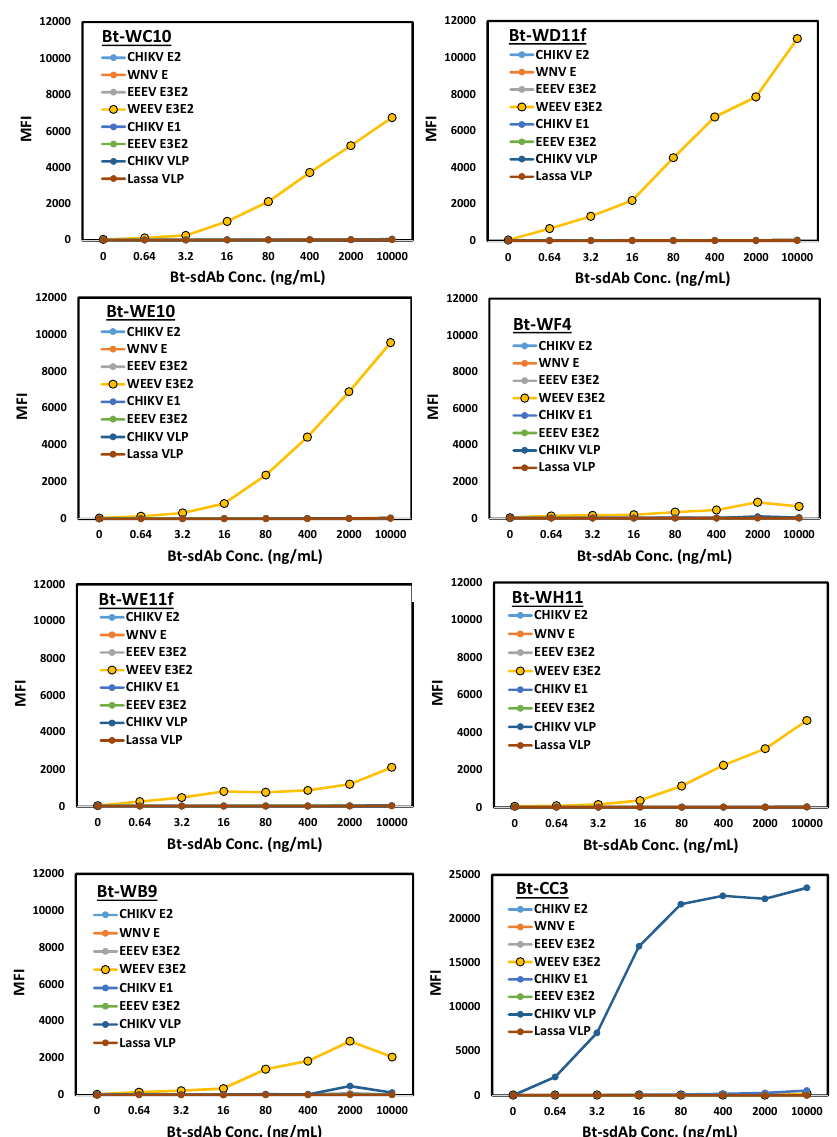
Figure 2. MagPlex direct binding assay to evaluate the specificity of the putative anti-WEEV E3E2 binding sdAb. Each sdAb was biotin labeled and mixed with MagPlex microspheres coated with various antigens at a range of concentrations. Biotinylated sdAb are denoted by Bt-clone name. Median fluorescence intensity versus Bt-sdAb concentration is plotted. The anti CHIKV sdAb CC3 was also tested as a positive control for the activity of the other sets of microspheres [49].